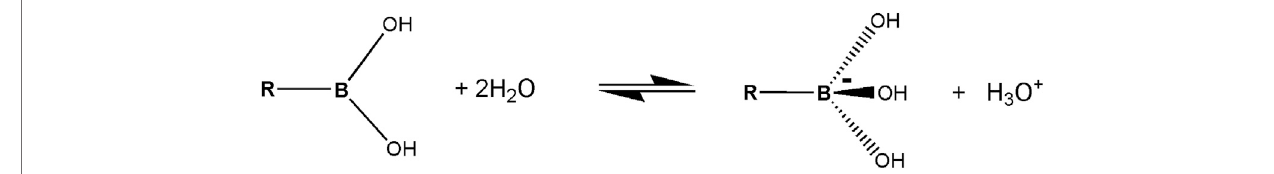
FIGURE 2 | A simpli fi ed diagram of the Lewis acid-base model of boronic acid in